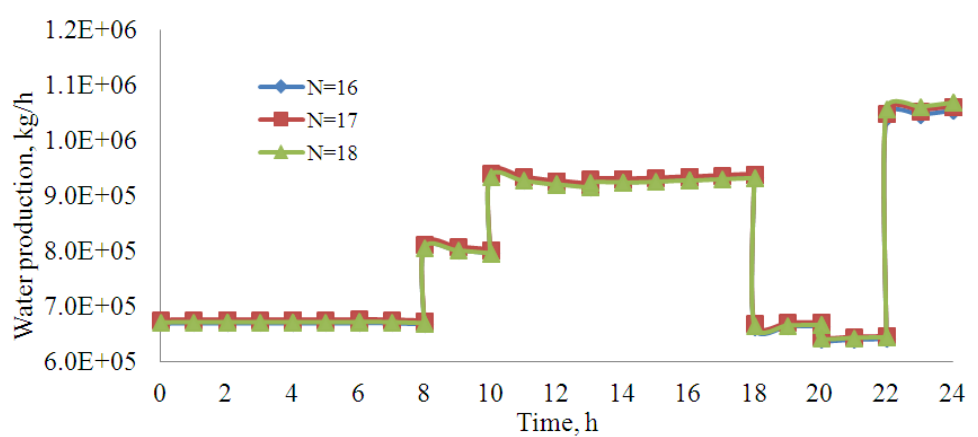
Figure 9. Fresh water plant production profile. Note: In y axis, E+05 = 10 5 and